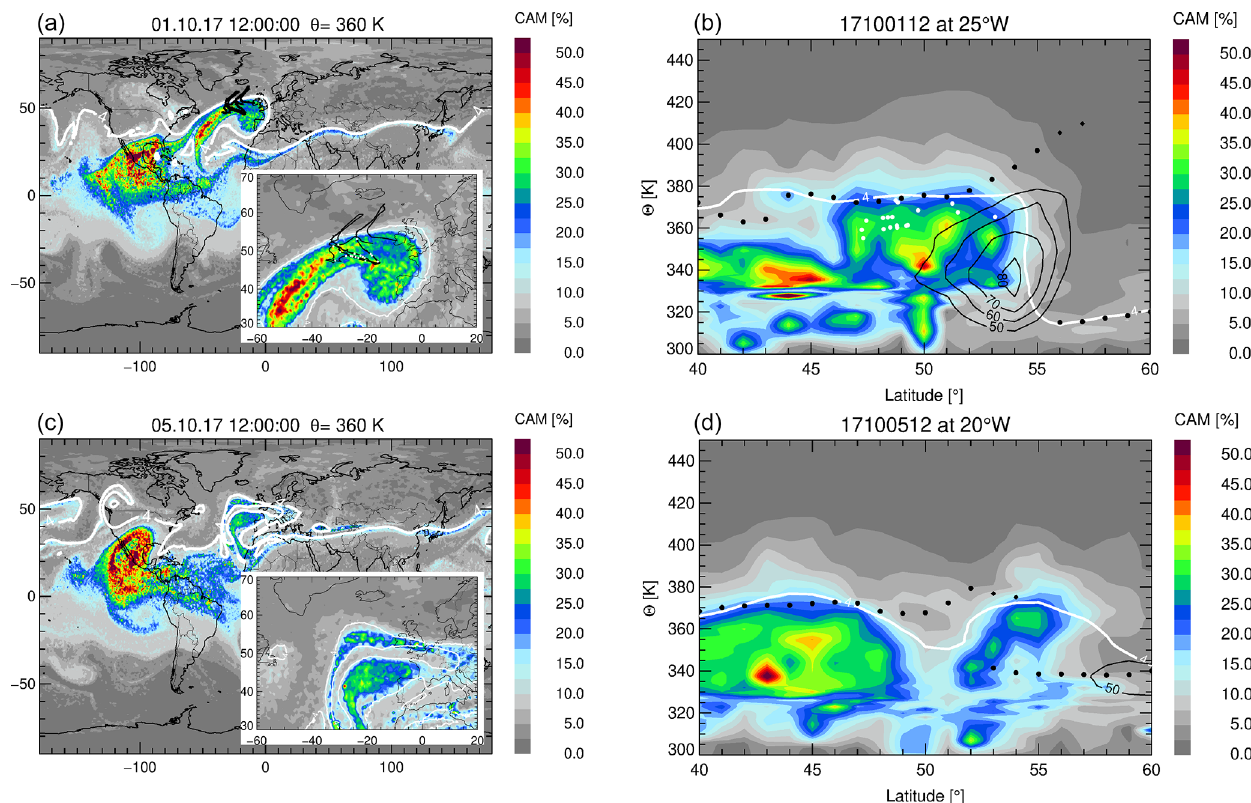
Figure 11. Meteorological situation at noontime (UTC) for the WISE flight on 1 October (a, b) and 4d later (c, d) using ERA-Interim reanalysis data. The colors indicate the absolute surface origin tracer fraction of the region of Central America (CAM) at 360K of potential temperature (a, c) and as a vertical cross section at 25 ◦ W (b) and 20 ◦ W (d) . The flight track (transferred to noontime) is shown as a black line on the isentropic view (a) ; on the vertical cross sections the black lines indicate zonal wind speed. White dots mark the measurement location of air that has been lifted up by Hurricane Maria. Note that these measurement locations, as well as the flight path shown, are not necessarily located exactly at 360K (a) or at 25 ◦ W (b) . Black dots indicate the location of the first thermal tropopause (TP); black diamonds indicate the second thermal TP; the white line shows the 4PVU surface. The plots show the probing of a high TP streamer of air originating in Central America at midlatitudes on 1 October. The streamer became unstable 4d later, and a large volume of tropical air mixed into the LS above the thermal TP. This figure illustrates the intrusion of tropical air into the LS: air within the streamer has been lifted up by a hurricane into the TTL and further transported to higher latitudes by an upper-level anticyclone above North America (see Fig. 8a) to be finally mixed into the LS by Rossby wave